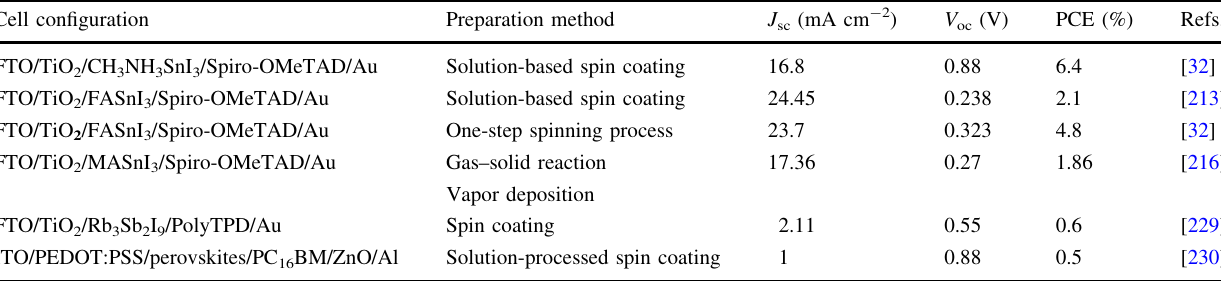
Table 10 Summary of recently reported improved lead-free perovskites Cell